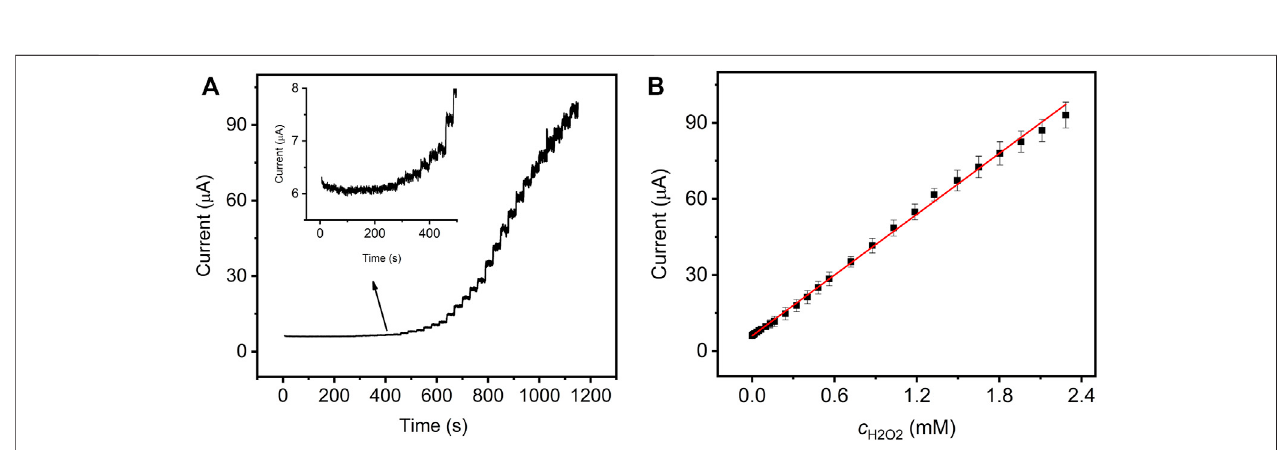
FIGURE 4 | (A) Amperometric response of GO – NMB/GCE with successive additions of H 2 O 2 in 0.1 M PBS (pH 7.0) at the applied potential of − 0.50 V. (B) Corresponding calibration plots between catalytic currents and H 2 O 2 concentrations.